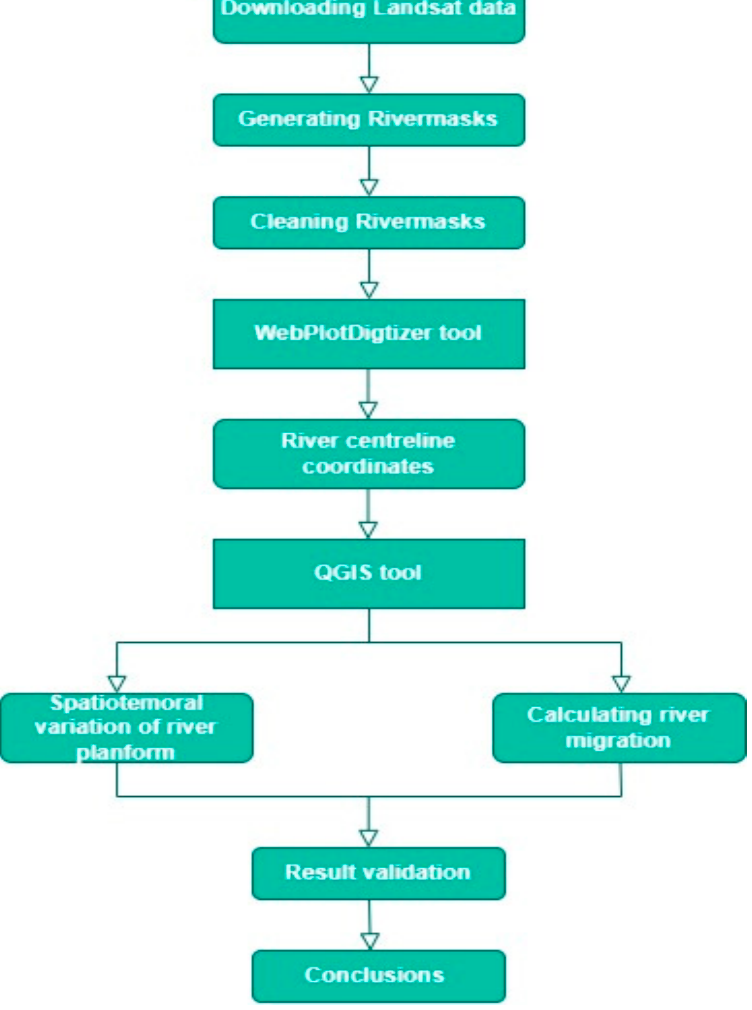
Figure 5 . Flowchart of the overall methodology of the study . Figure 5. Flowchart of the overall methodology of the